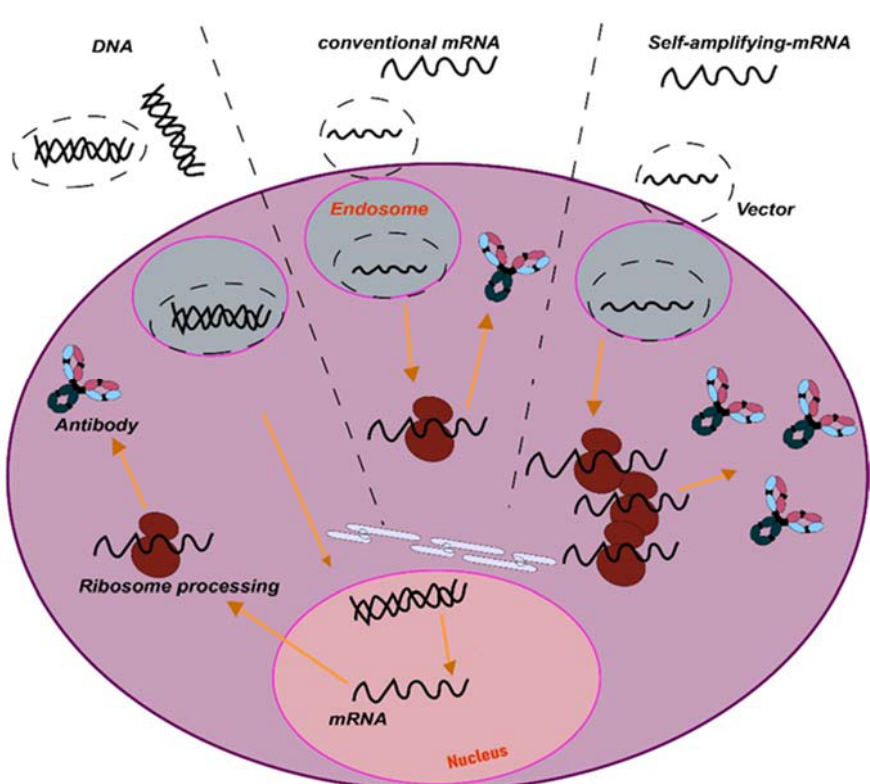
Figure 2. Schematic representation of nucleic acid delivery systems. Liposome-transported DNA is internalized through endocytosis, or by physical means such as electroporation. Inside the cell, DNA is imported into the nucleus, where it will be transcribed. Both conventional and self-amplifying RNAs require a delivery system for cell uptake by endocytosis, which it is followed by release from the endosome into the cytoplasm. Then, the mRNA is immediately translated. For replicons, the RNA is translated into replicase proteins that will auto-amplify the RNA, including antigen-encoding subgenomic mRNAs, leading to large quantities of the encoded antigen.